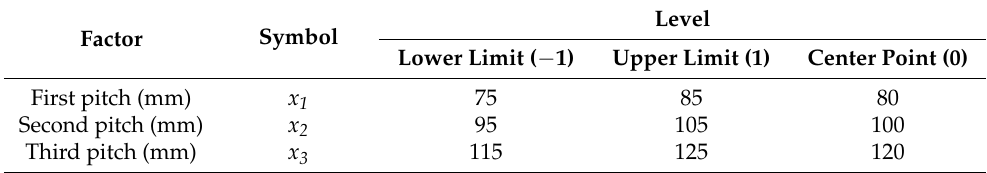
Table 1. Three-Stage Variable Pitch CCD Test Factor Level Design.